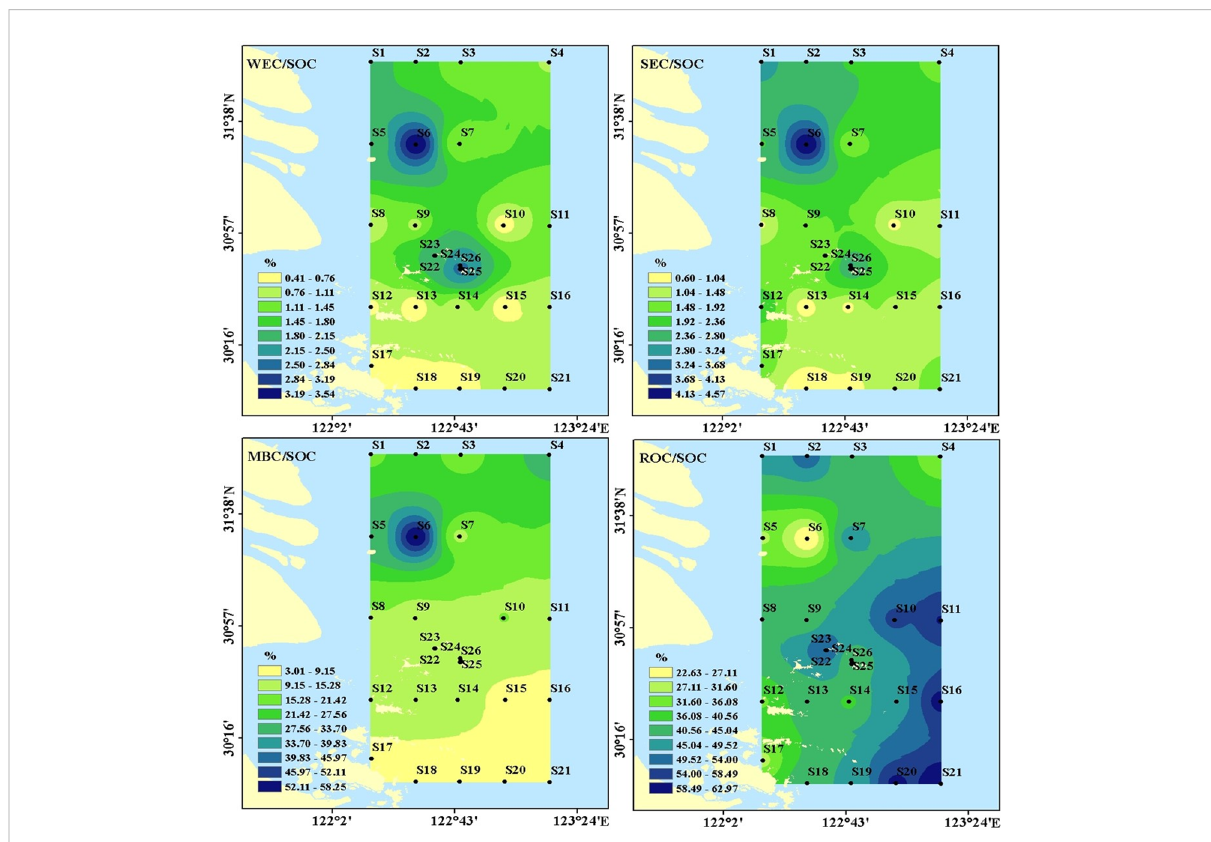
FIGURE 5 Distribution of WSOC/SOC, SEC/SOC, MBC/SOC, ROC/SOC in the surface sediments off the Changjiang Estuary and adjacent